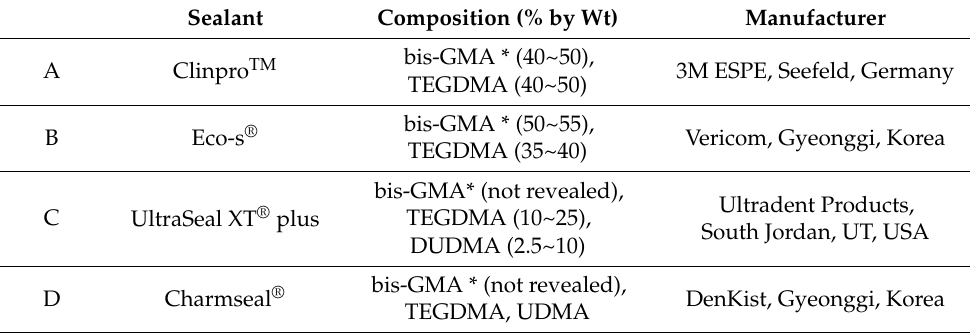
Table 1. The compositions of the sealants were tested, according to the manufacturers’ information. Sealant Composition (% by